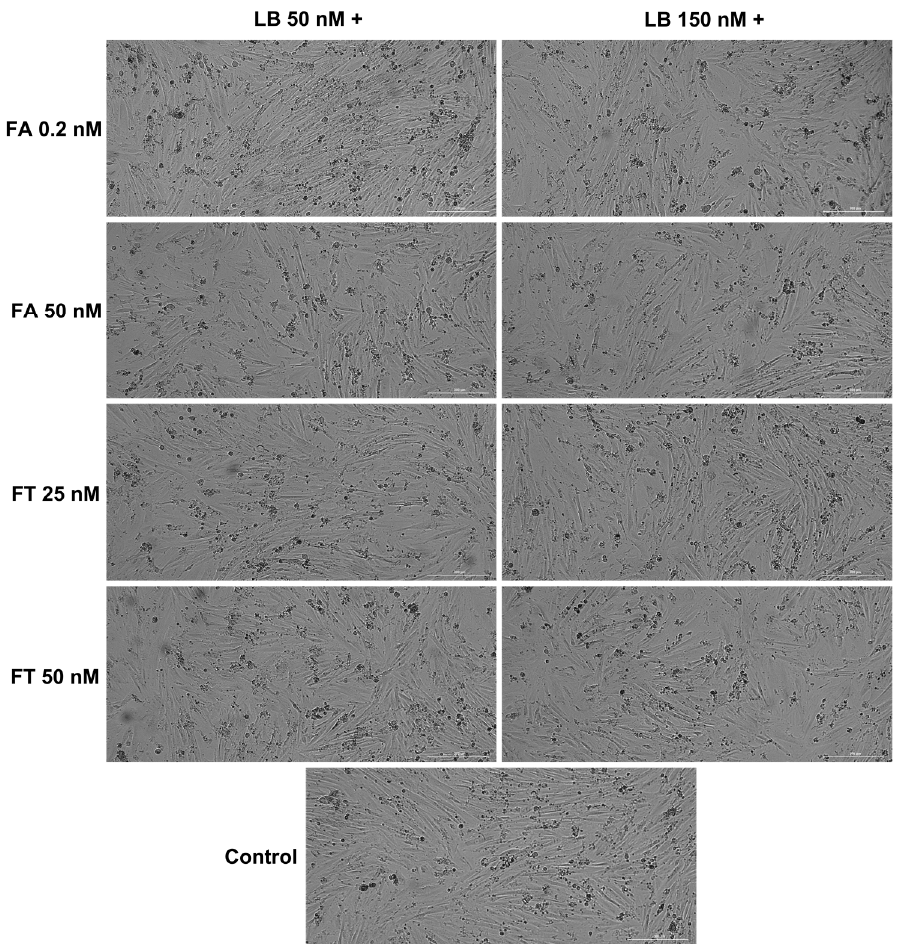
Figure 3. Morphological analysis of H9c2(2-1) myoblasts following the 72-h combined treatment of LB 50 and 150 nM with FA (0.2 and 50 nM) and FT (25 and 50 nM).